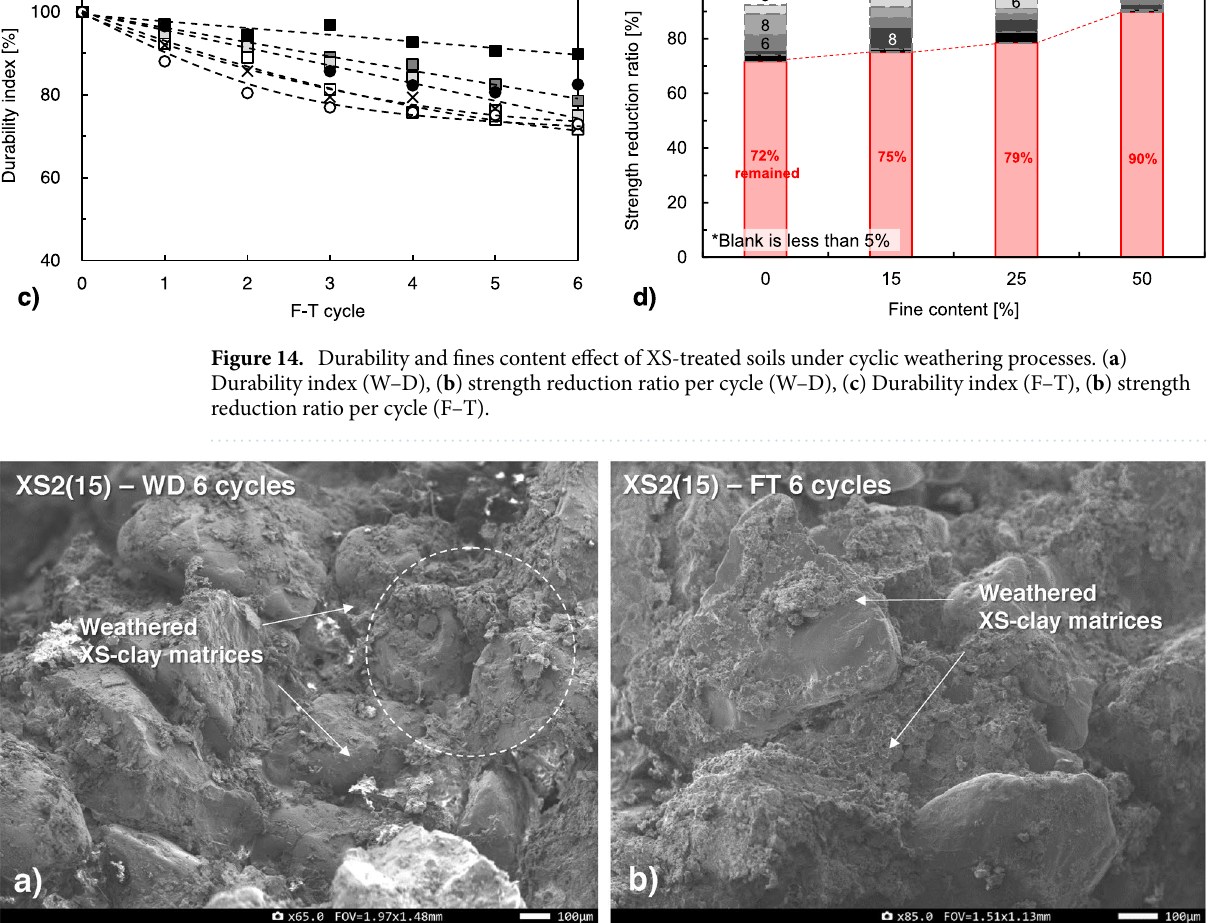
Figure 15. SEM images of XS2(15) after 6 weathering cycles. ( a ) W–D, and ( b )